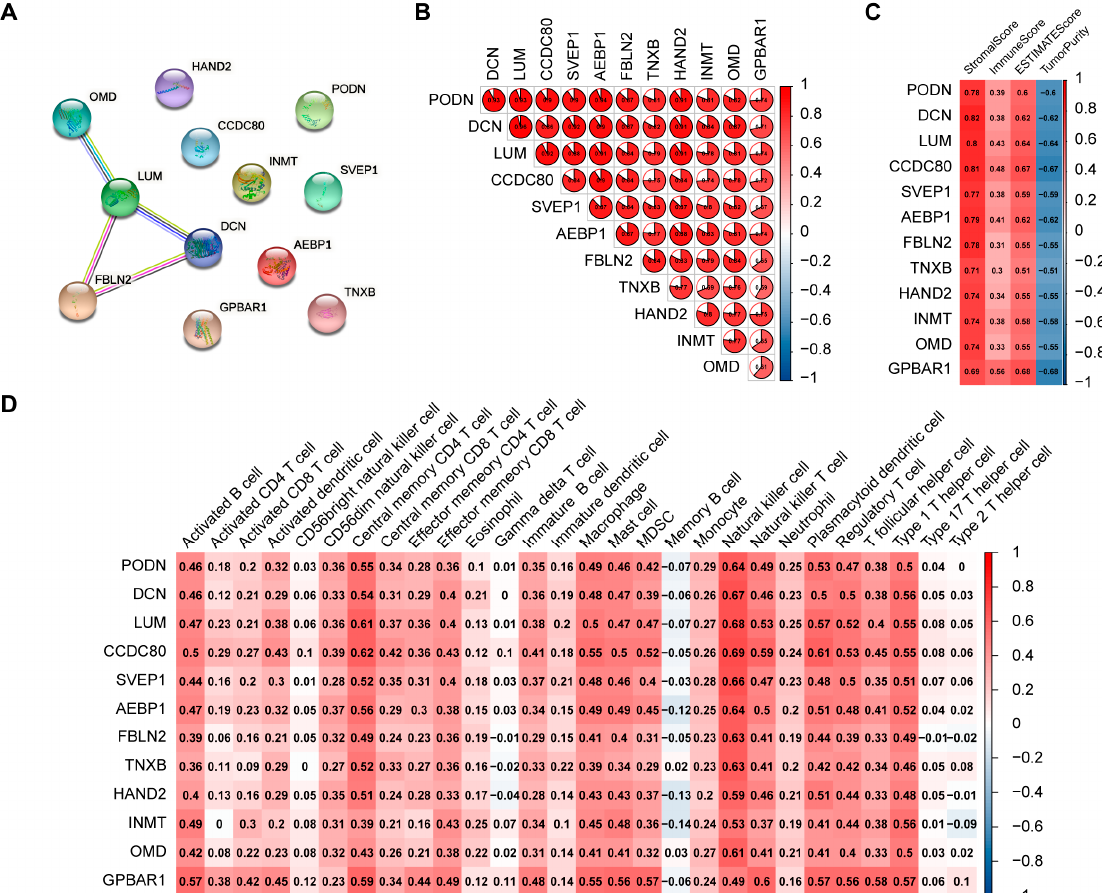
Figure 5. Determination of the functions of hub genes. ( A ) PPI network of hub genes. ( B ) Spearman rank correlation analysis among hub genes. ( C ) Correlation between hub genes and the stromal score, immune score, ESTIMATE score, and tumor purity of ESTIMATE. ( D ) Correlation analysis between hub genes and the expression of immune cells by ssGSEA.